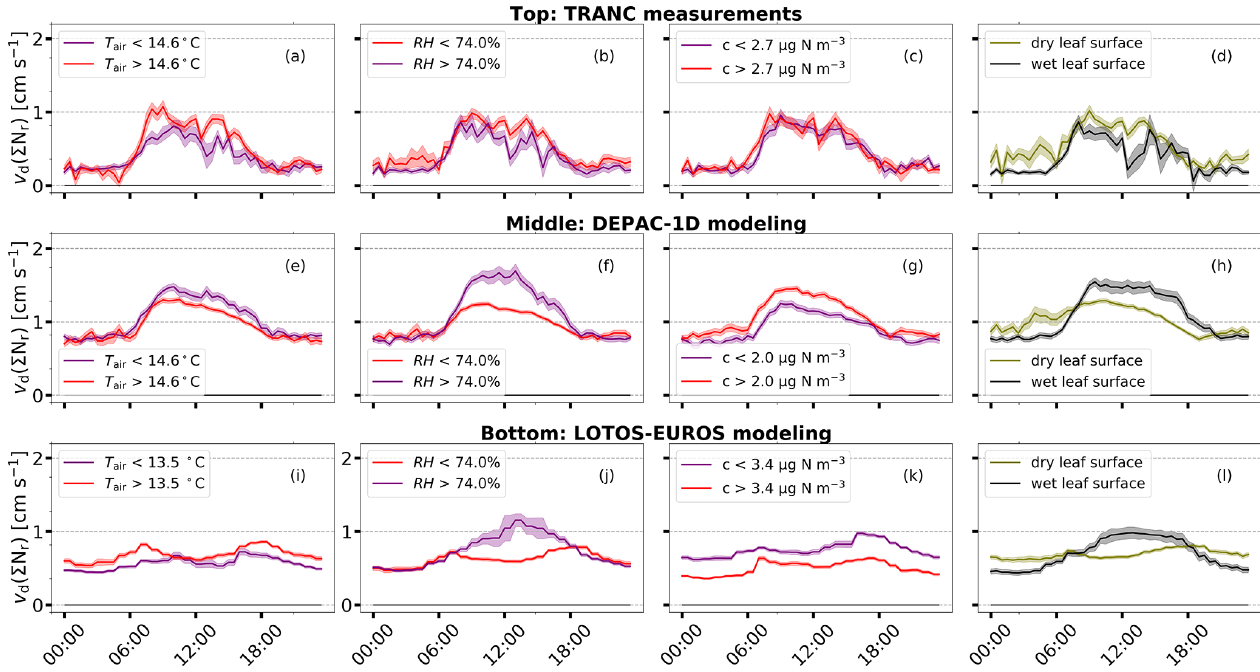
Figure 4. Averaged diurnal cycles of (cid:54) N r v d for low and high temperature, relative humidity, and concentration during the timeframe May– September. The top row refers to TRANC measurements (a–d) , the middle row refers to DEPAC-1D modeling (e–h) , and the bottom row refers to LOTOS-EUROS simulations (i–l) . Data were stratified after their median was calculated for the entire period. Dry and wet leaf surfaces (d, h, l) were identified following the calculation scheme of Wintjen et al. (2022). Shaded areas represent the standard error of the